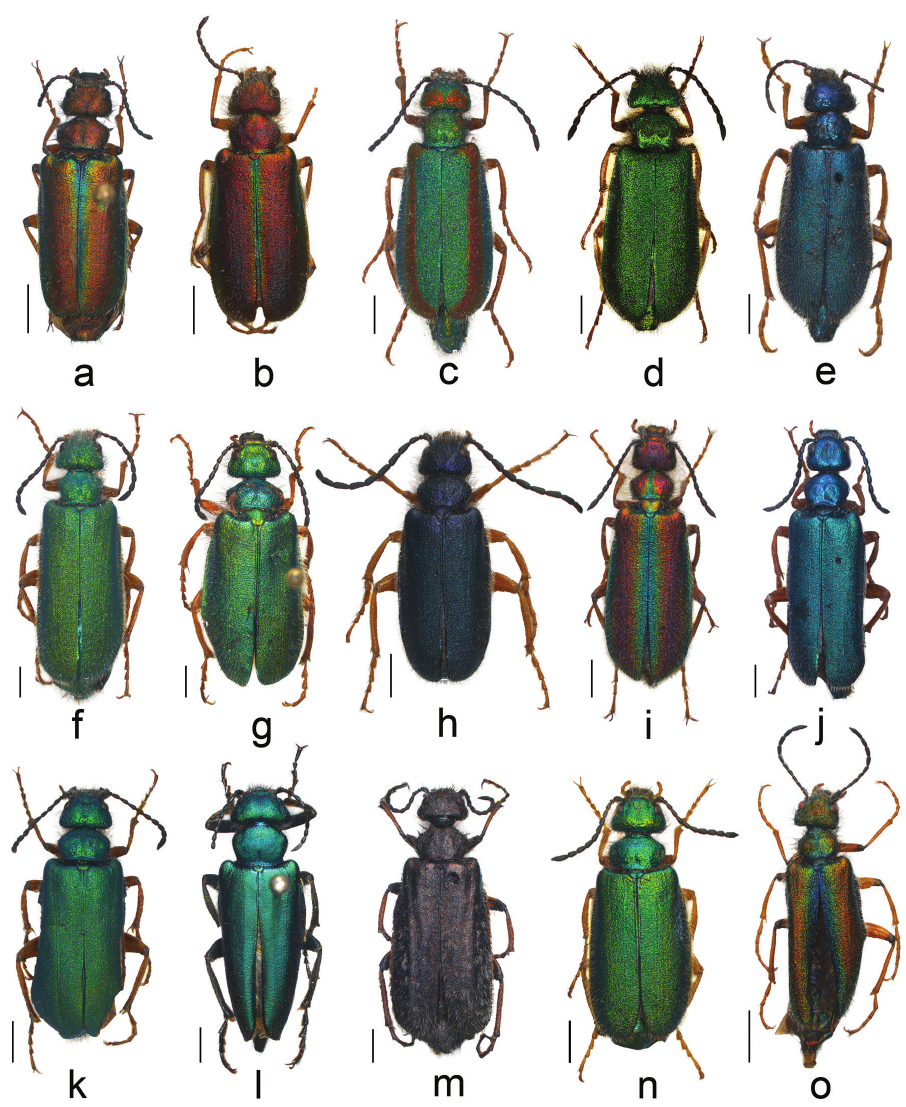
Figure 4. Females of the genus Teratolytta : a Teratolytta sp. A (sp. n. ?) b T. carlae c T. dives , striped phenotype d T. dives , unicoloured phenotype e T. eylandti f T. flavipes g T. gentilis , typical phenotype h T. gentilis , blue phenotype i T. kaszabi j T. klapperichi k T. monticola l T. optabilis m T. pilosella n T. taurica o T. vanensis . Scale bars 2